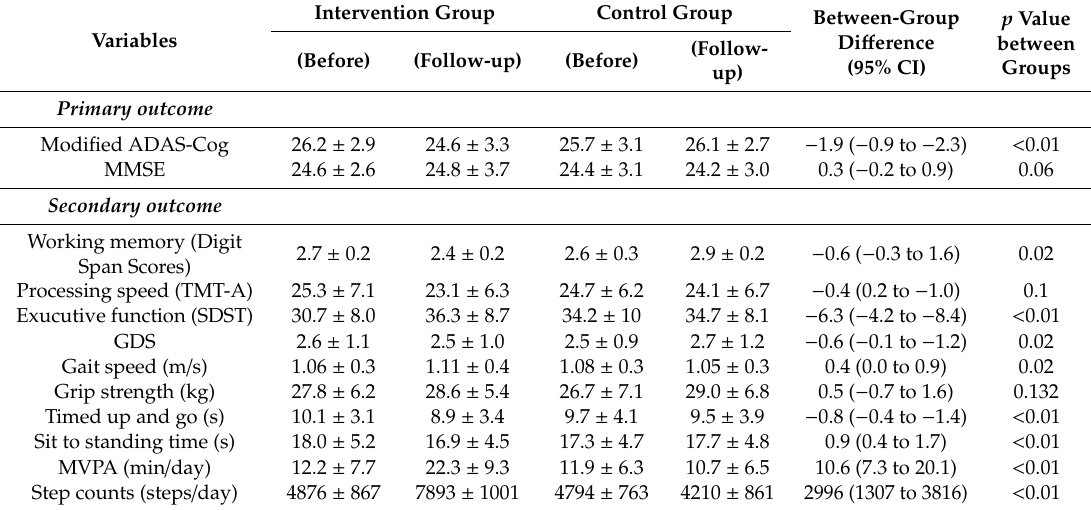
Table 1. Adjusted comparisons of change in measurements from baseline and 24 in intervention group and control group.